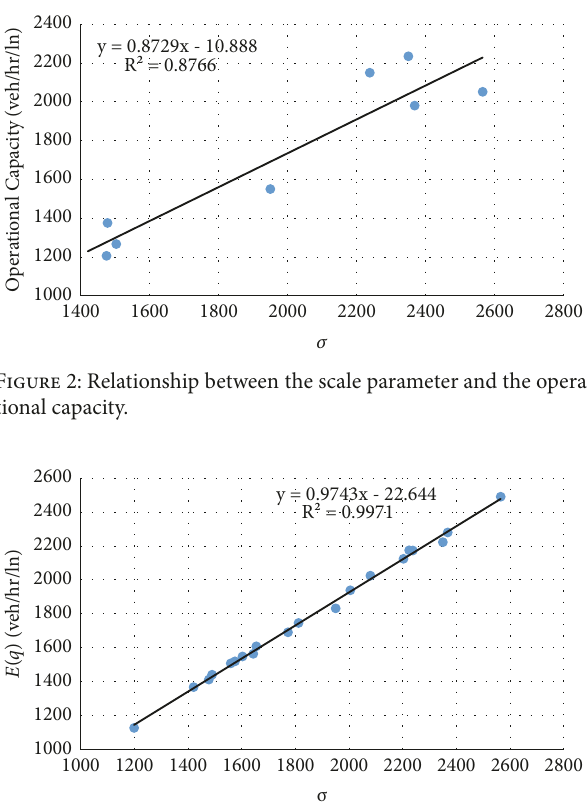
Figure 3: Relationship between the scale parameter and the mean